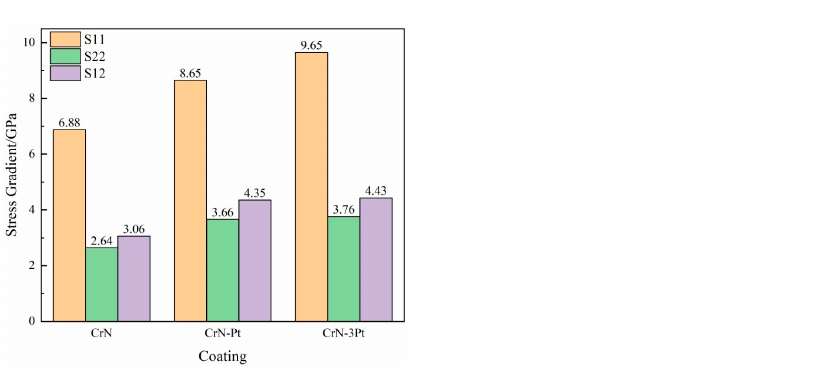
Figure 17. Distribution of residual stress at the interface between three coatings and substrate. ( a ) CrN; ( b ) CrN-Pt; ( c ) CrN-3Pt.